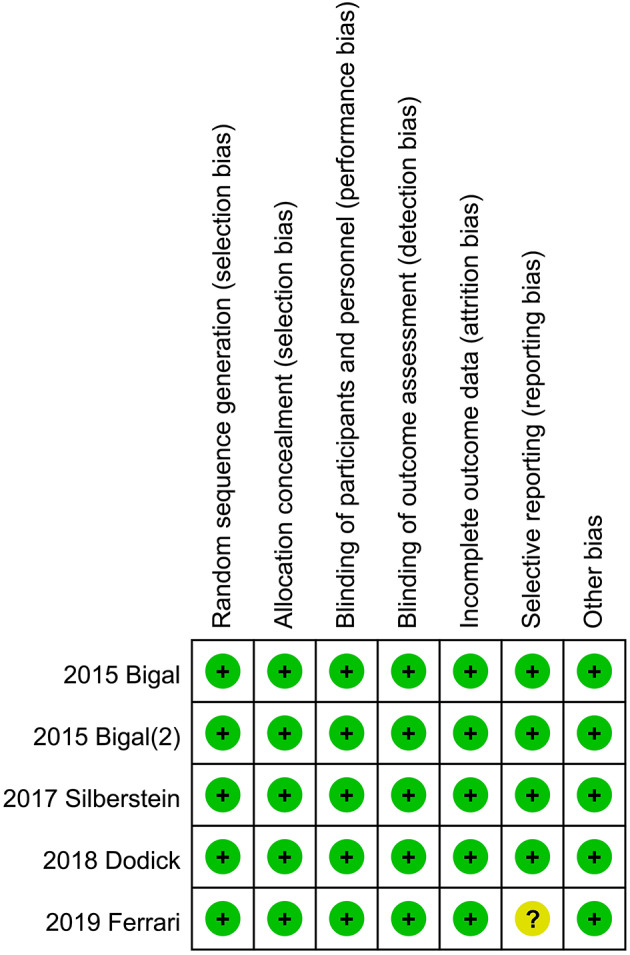
Risk of bias: a summary table for each risk of bias item for each study.